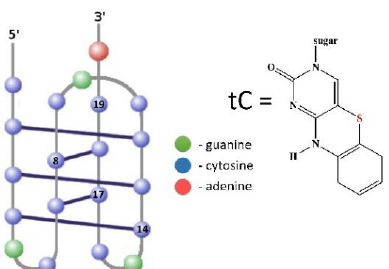
Figure 1. Structure of intramolecular i-motif formed by 8tC, 14tC, 17tC, and 19tC probes. The positions of the single fluorescent cytosine analog substitutions are numbered and blue circles—cytosines, green circles—guanines, and red circles—adenines. Table 1. Oligonucleotides used in this study and their respective sequences.